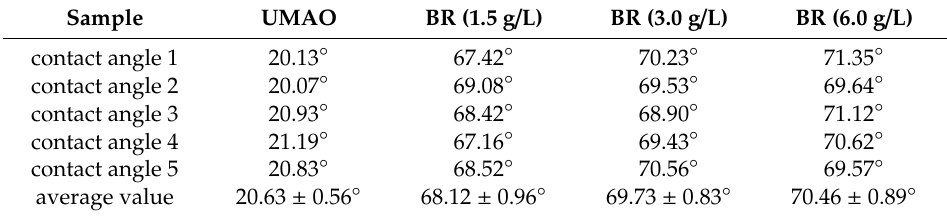
Figure 4. Contact angles of UMAO and coatings with BR on pure magnesium: ( a ) UMAO; ( b ) UMAO/PLGA/BR1.5; ( c ) UMAO/PLGA/BR3.0; ( d ) UMAO/PLGA/BR6.0. Table 2. Contact angle of various coatings. UMAO, ultrasonic micro-arc oxidation; BR, berberine.